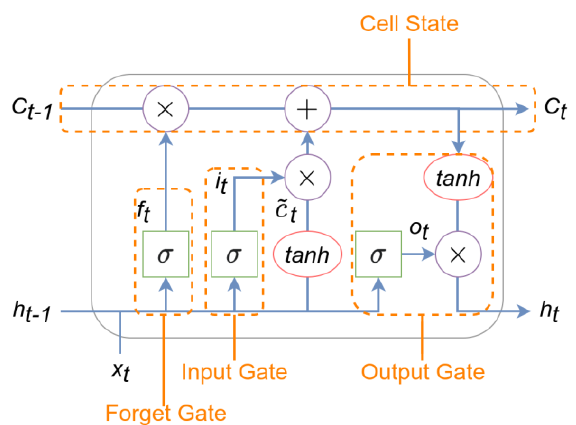
Figure 3. Anatomy of a LSTM